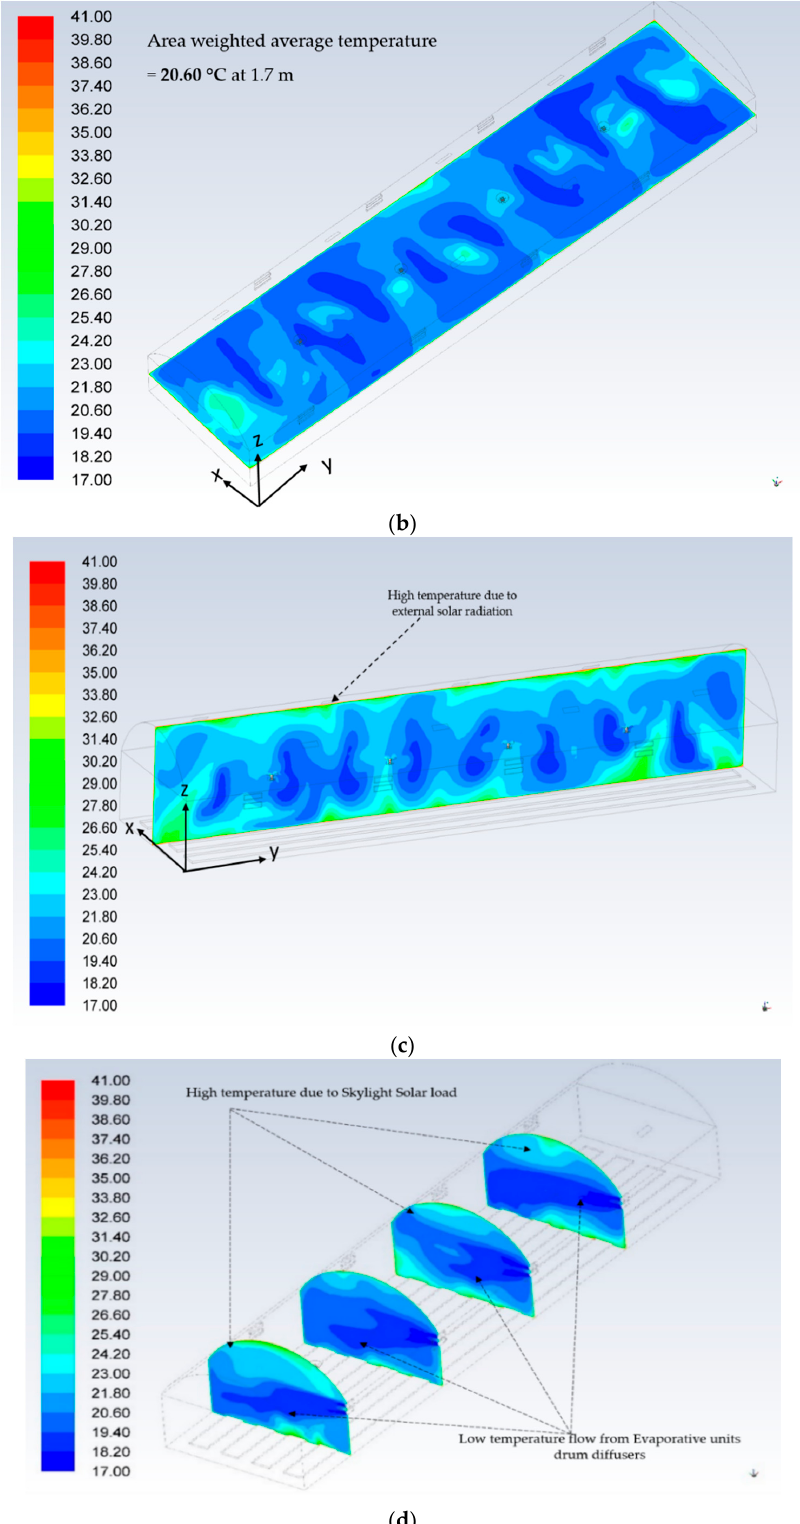
Figure 8. ( a ) Contour plot of temperature ( ◦ C) at a height of 1 m (XY plane). ( b ) Contour plot of temperature ( ◦ C) at a height of 1.7 m (XY plane). ( c ) Contour plot of temperature ( ◦ C) on (YZ plane) along the length. ( d ) Contour plot of temperature (in ◦ C) along XY plane along length of greenhouse at different evaporative cooler